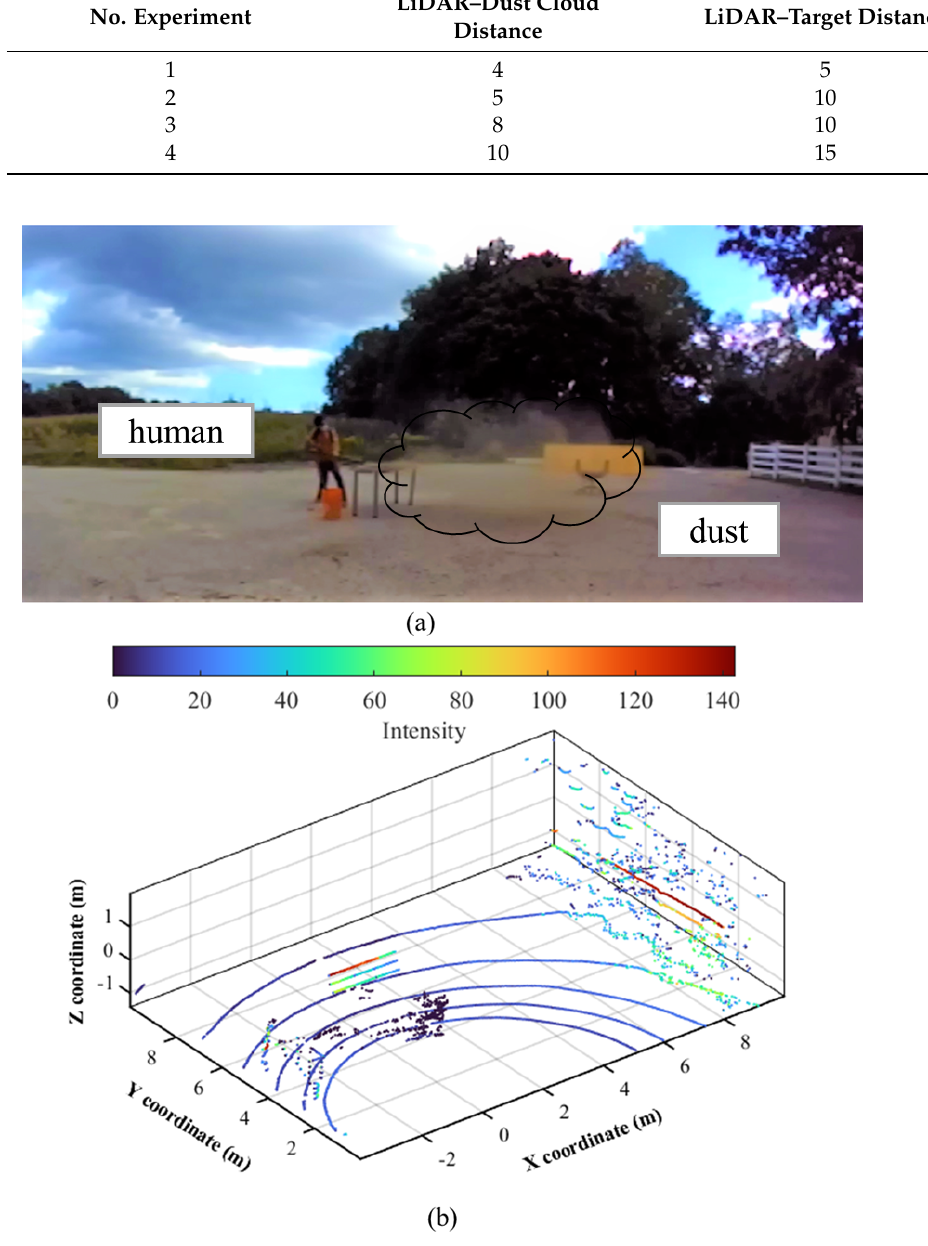
Figure 2. A scene of experimental data collection ( a ) and corresponding point cloud ( b